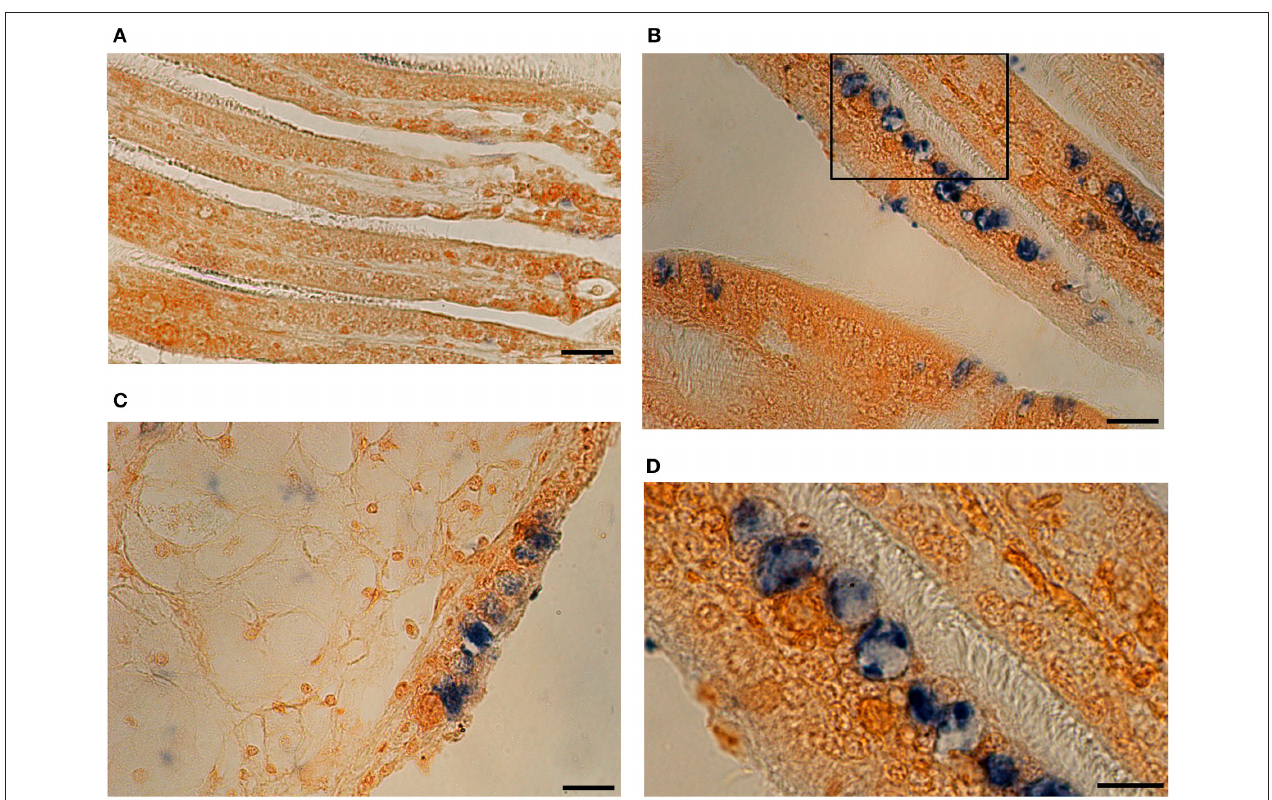
FIGURE 9 | In situ Hybridization photomicrographs of an uninfected oyster (A) and a heavily infected individual (B–D) . OsHV-1 DNA is marked in blue. (B) Gill tissue section with strong blue labeling in epithelia. (C) Section showing mantle tissue and epithelial cells. (D) Detail of picture (B) showing positive marked cells. (Scales bars A–C : 20 µ m; D : 10 µ